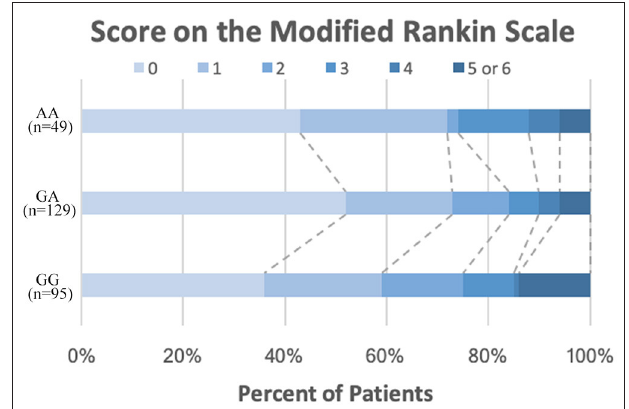
FIGURE 2 | Distribution of scores on the modified Rankin scale at 2 years. The distribution of scores for disability on the modified Rankin scale among patients by different PEAR1 rs12041331 genotype ranges from 0 to 6, with higher scores indicating more severe disability.